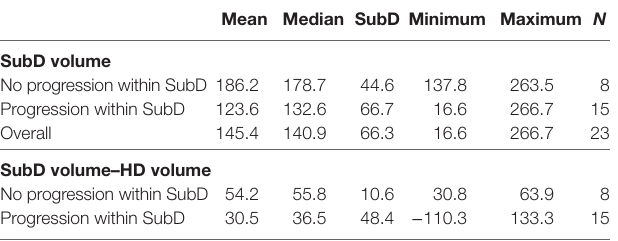
Table 2 | Comparison of isodose SubD volume and difference between SubD and high-dose (HD) volumes in cases of progression.